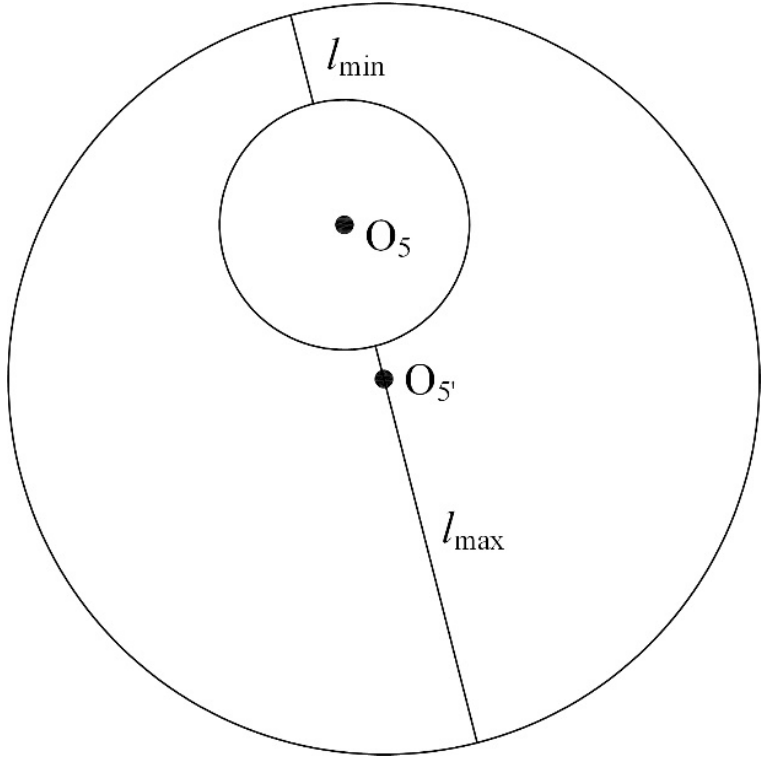
Figure 17. Measurement method of the offset between the bolt and nut sleeve.